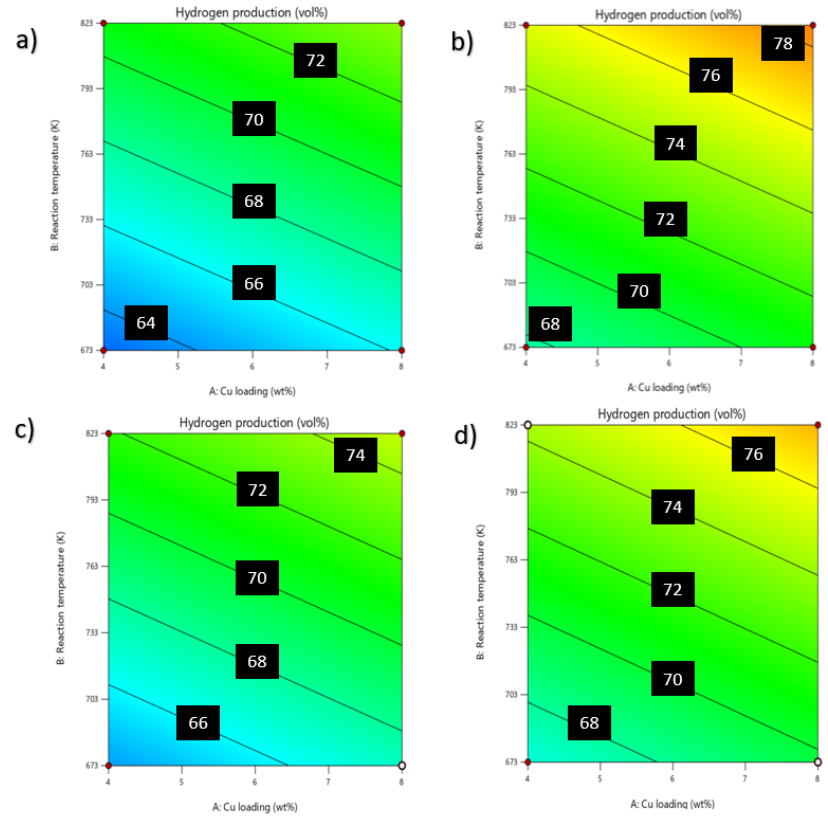
Figure 3. Counter plot for Y2 on reaction temperature vs. Cu loading: ( a ) WHSV and glycerol concentration are in minimum conditions; ( b ) WHSV and glycerol concentration are in maximum conditions; ( c ) WHSV is in minimum condition and glycerol concentration is in maximum condition; and ( d ) WHSV is in maximum condition and glycerol concentration is in minimum condition. (The black box indicates that the highest hydrogen production can be obtained in the selected boundaries.)